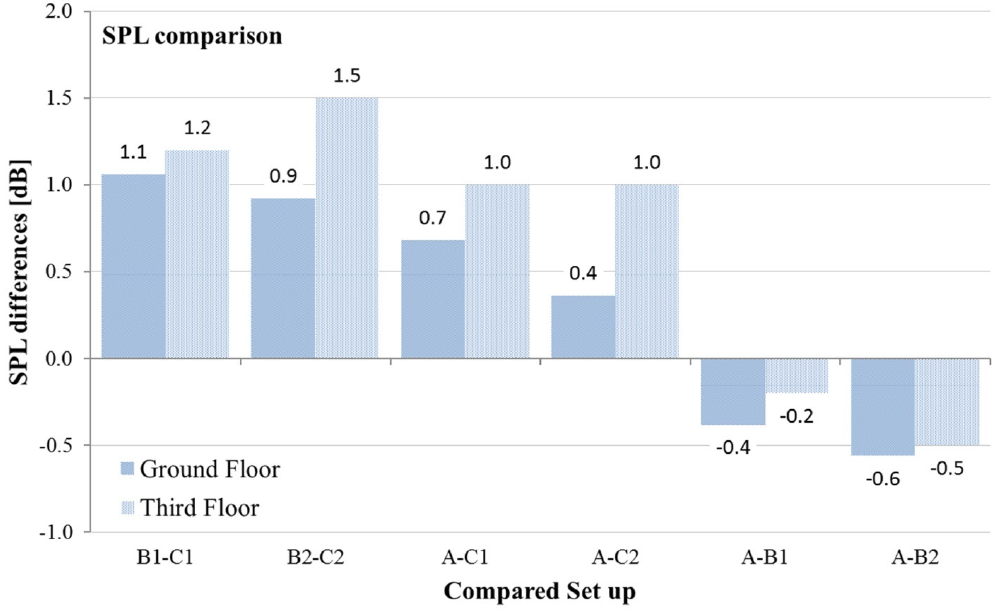
Figure 14. Comparison of global average SPL differences in dB of the studied configurations A, B1, B2, C1, C2, on the ground and third